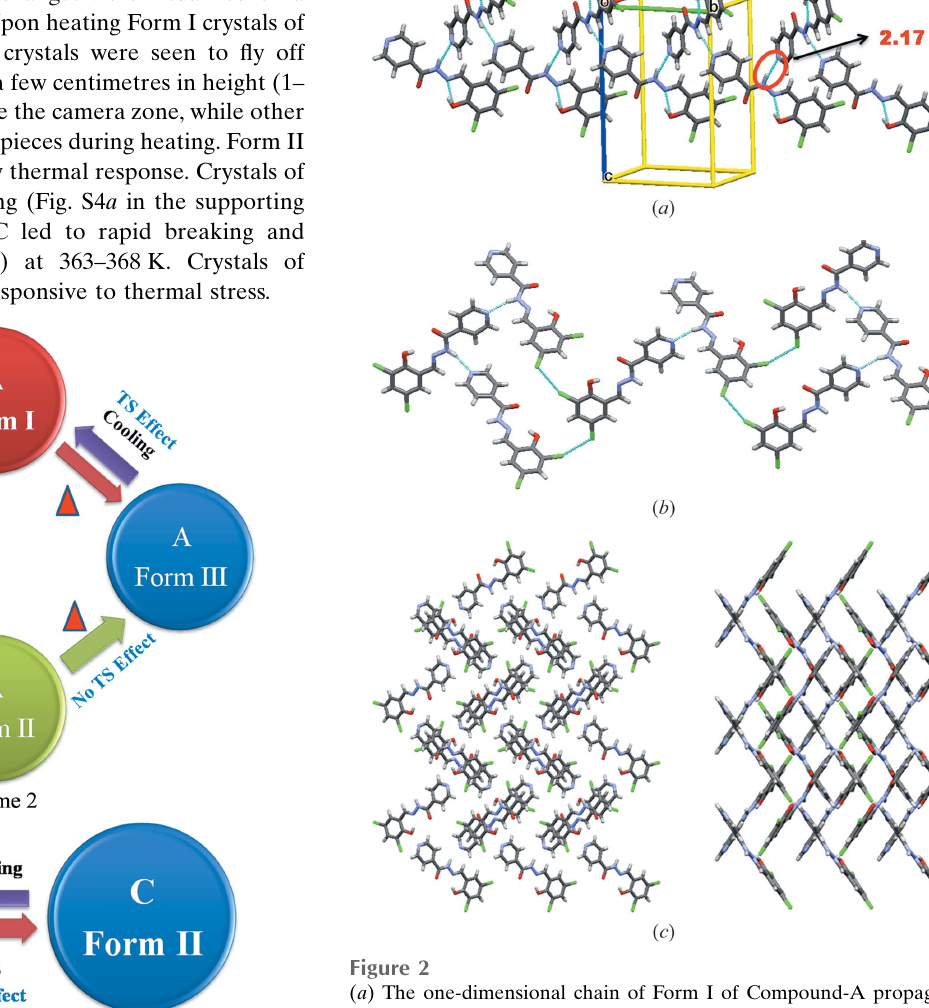
Figure 2 ( a ) The one-dimensional chain of Form I of Compound-A propagating through the N—H (cid:2)(cid:2)(cid:2) N (pyridine) synthon. ( b ) Type II halogen bonding. ( c ) Packing of molecules along the a and c axes (Form